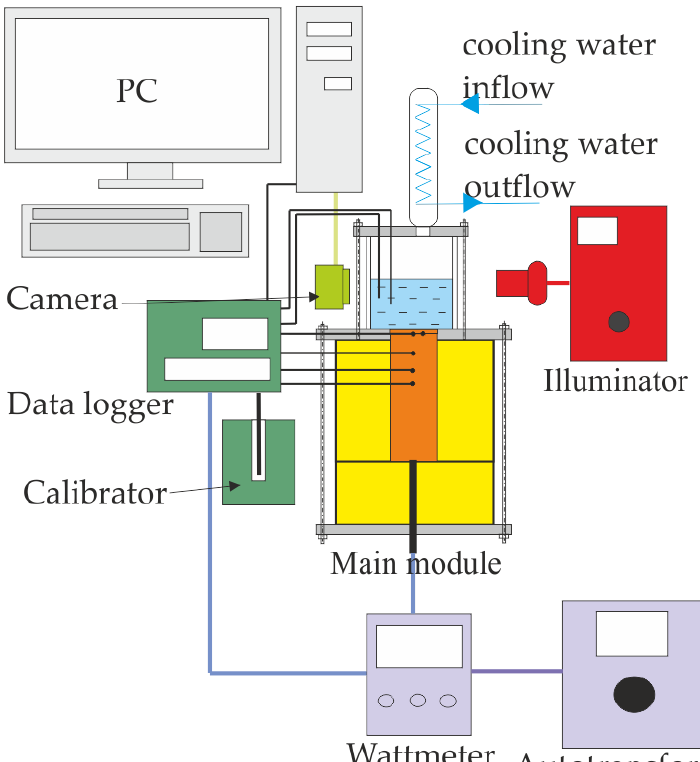
Figure 1. Test stand